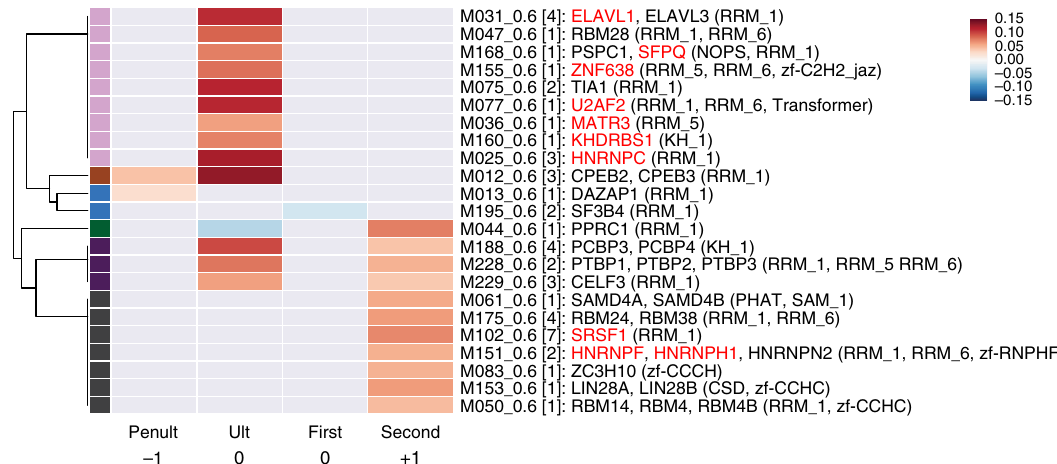
Fig. 5 Heatmap showing signi fi cant RBP motif density differences in CG sequences. Heatmap is for all HCT116 and 184hTERT CGs compared to non-CG sequences. X -axis represents four CG sequence regions: penultimate ( − 1 exon) exon, last exon (0, terminal exon of upstream participant), fi rst exon downstream (0, fi rst exon of downstream participant), second exon (+1, downstream partner). Only one motif per RBP family is shown, the number of motifs in square brackets . Y -axis shows the RBP motif id and RBP name (highlighted red : CLK interactors) and protein domains associated with the listed motif. Cells with non-signi fi cant differences are colored gray . Colored cells represent a positive ( red ) or negative ( blue ) effect size. Color bars on the left y - axis represent a possible motif cluster assignment based on signi fi cance and effect size